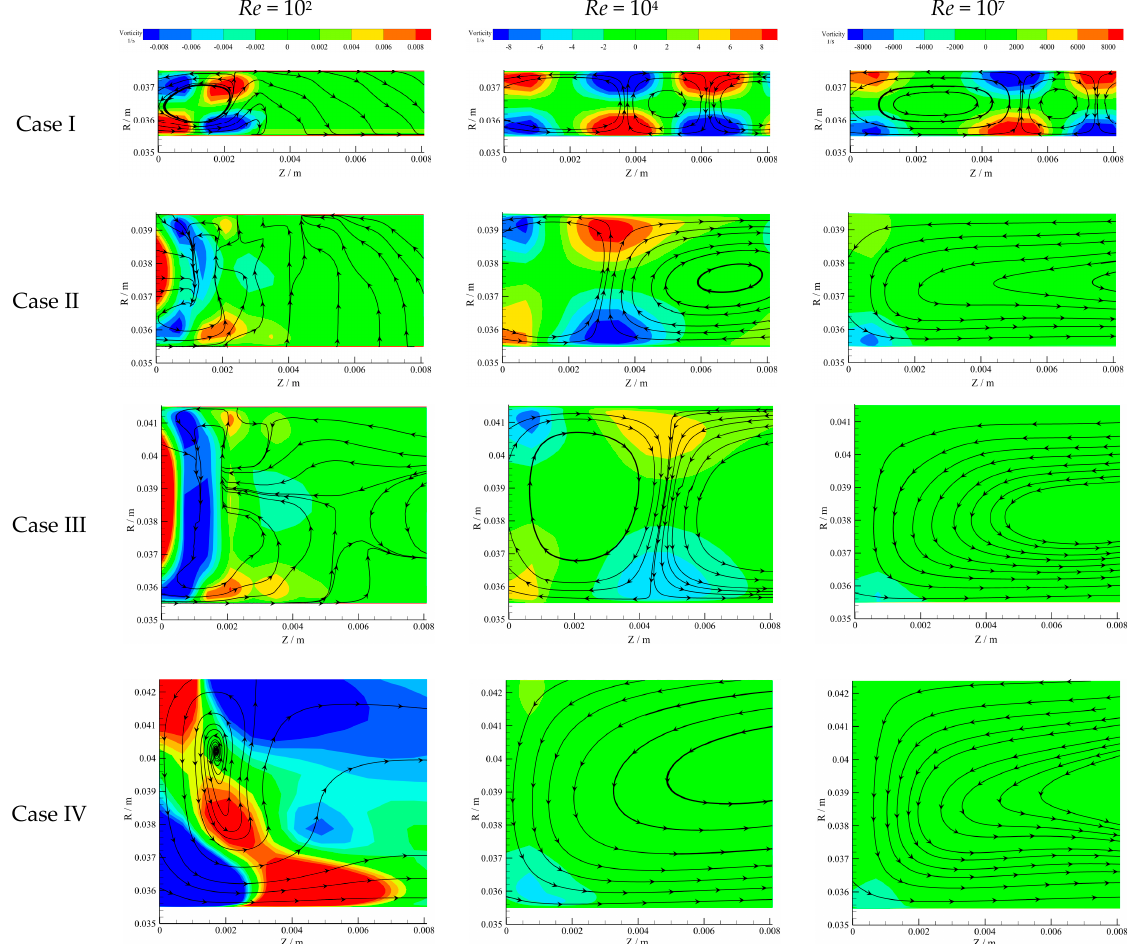
Figure 13. Streamlines and vorticity contours at meridional plane with Re of 10 2 , 10 4 , and 10 7 at different η = 0.056~0.225.